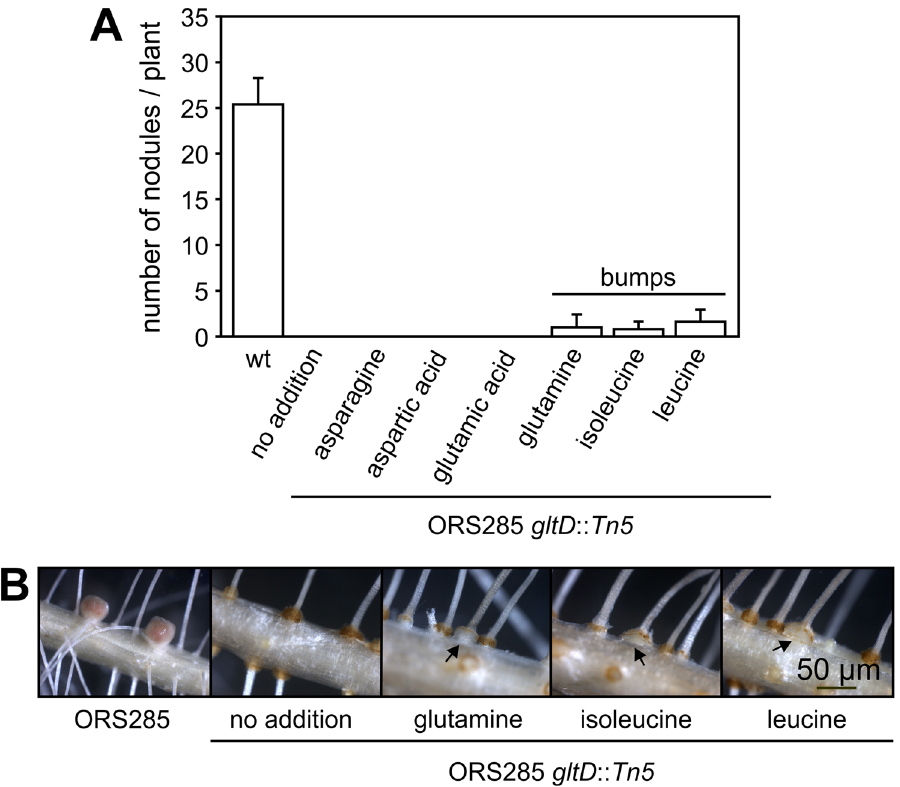
Figure 5. Amino acid supplementation does not restore the symbiotic phenotype of the Bradyrhizobium gltD::Tn5 mutant with A. evenia plants. ( A ) A. evenia plants were inoculated with the Bradyrhizobium ORS285 gltD::Tn5 mutant in the presence of 0.5 mM of the indicated amino acid and at 21 dpi the number of nodules (cq. bumps) was determined. ( B ) mature nodules induced by wild-type ORS285 and small bumps induced by the ORS285 gltD::Tn5 mutant strain in the presence of 0.5 mM glutamine, isoleucine or leucine on A. evenia roots.